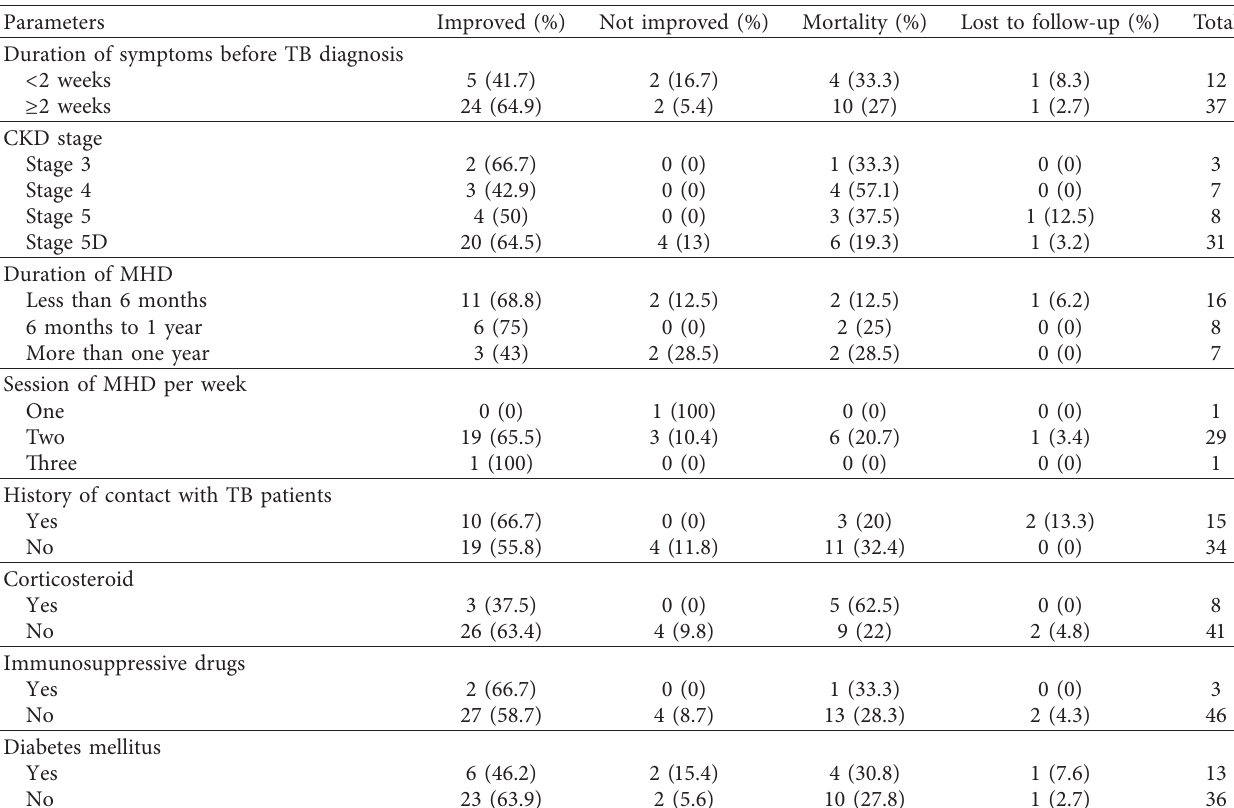
Table 8: Factors affecting outcomes of TB patients at two months of starting ATT.